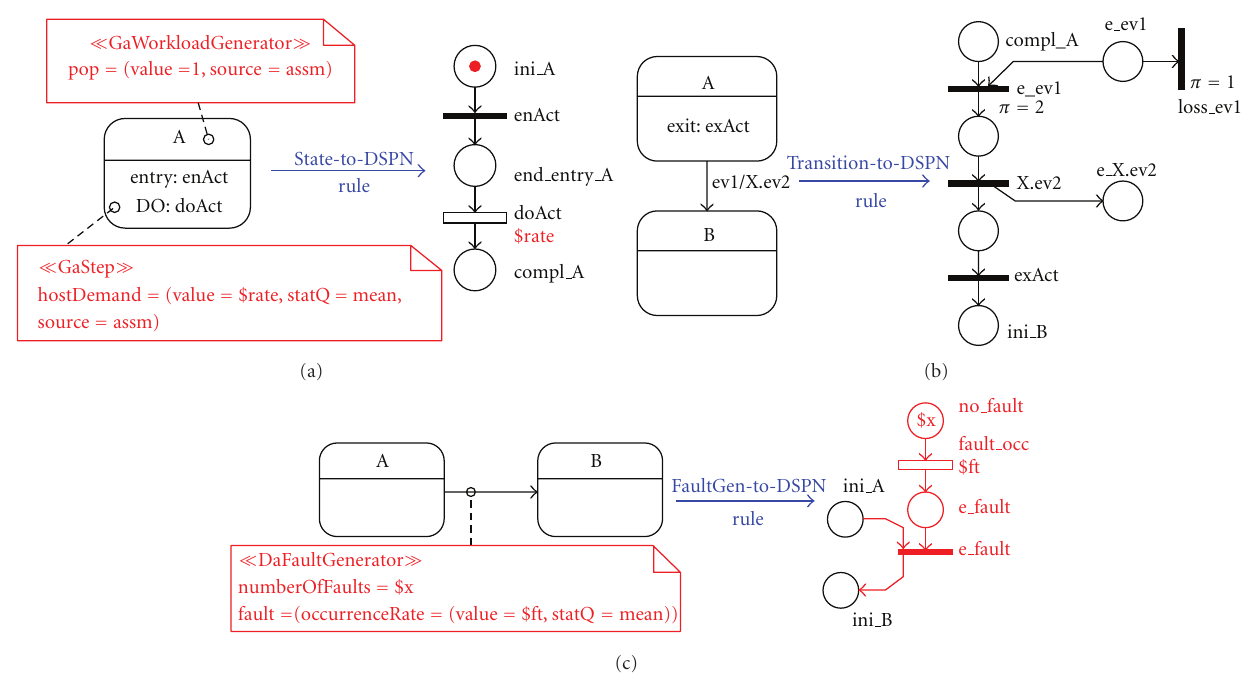
Figure 3: SM-to-DSPN